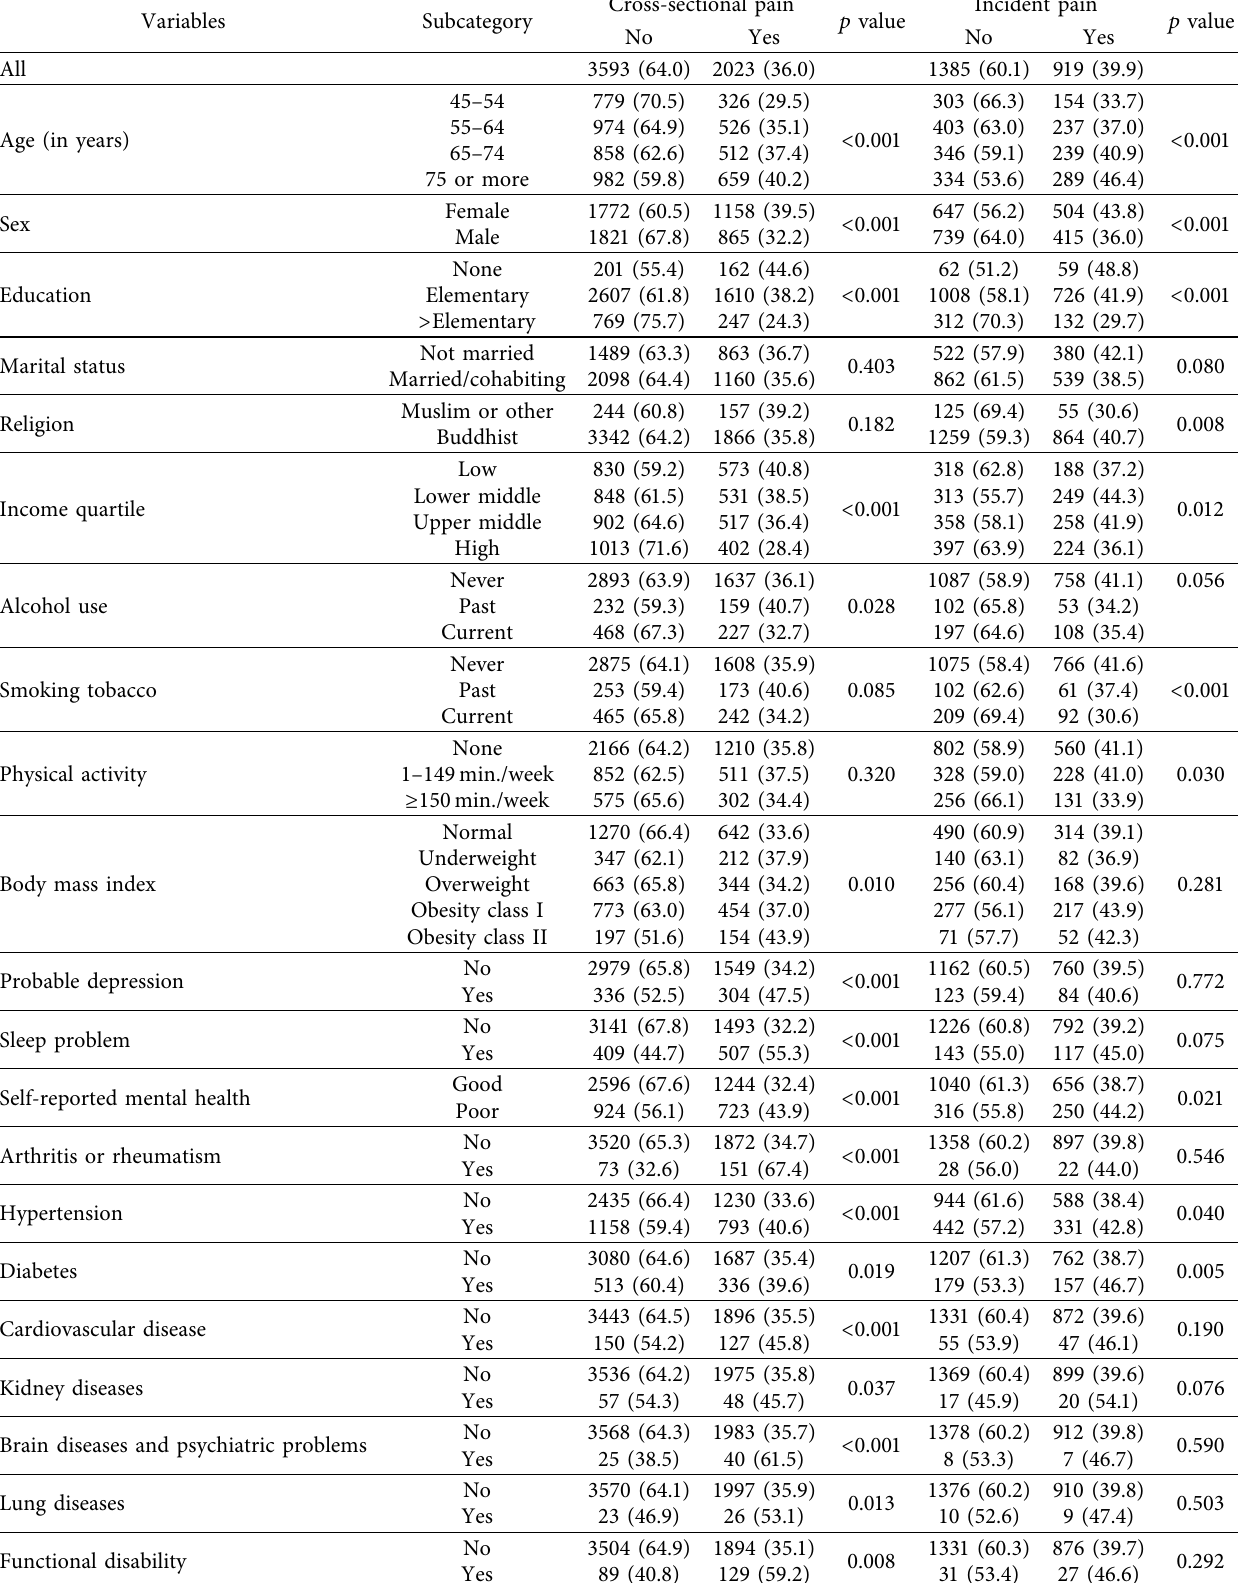
Table 1: Demographic factors and health status by cross-sectional and incident